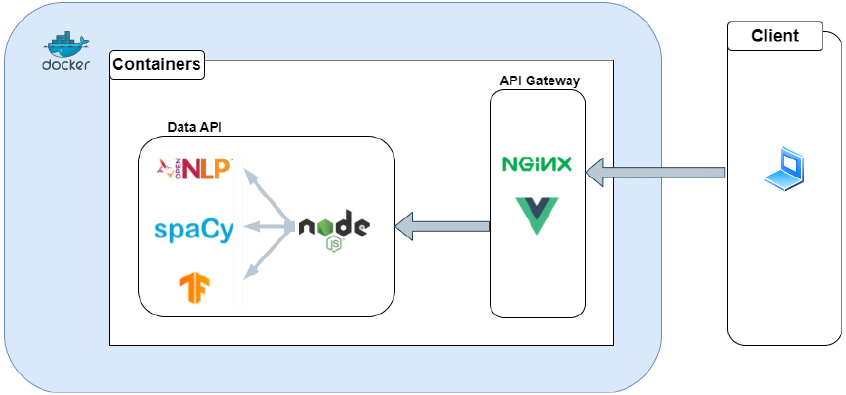
Figure 14. NER@DI